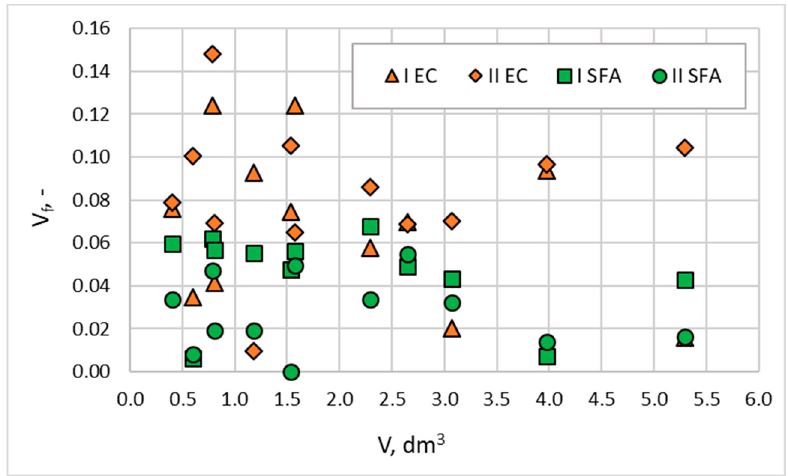
Figure 8. The relationship between cored specimen volume ( V ) and the coefficient of variation of strength determined for particular specimen types ( V f ) (wet condition).